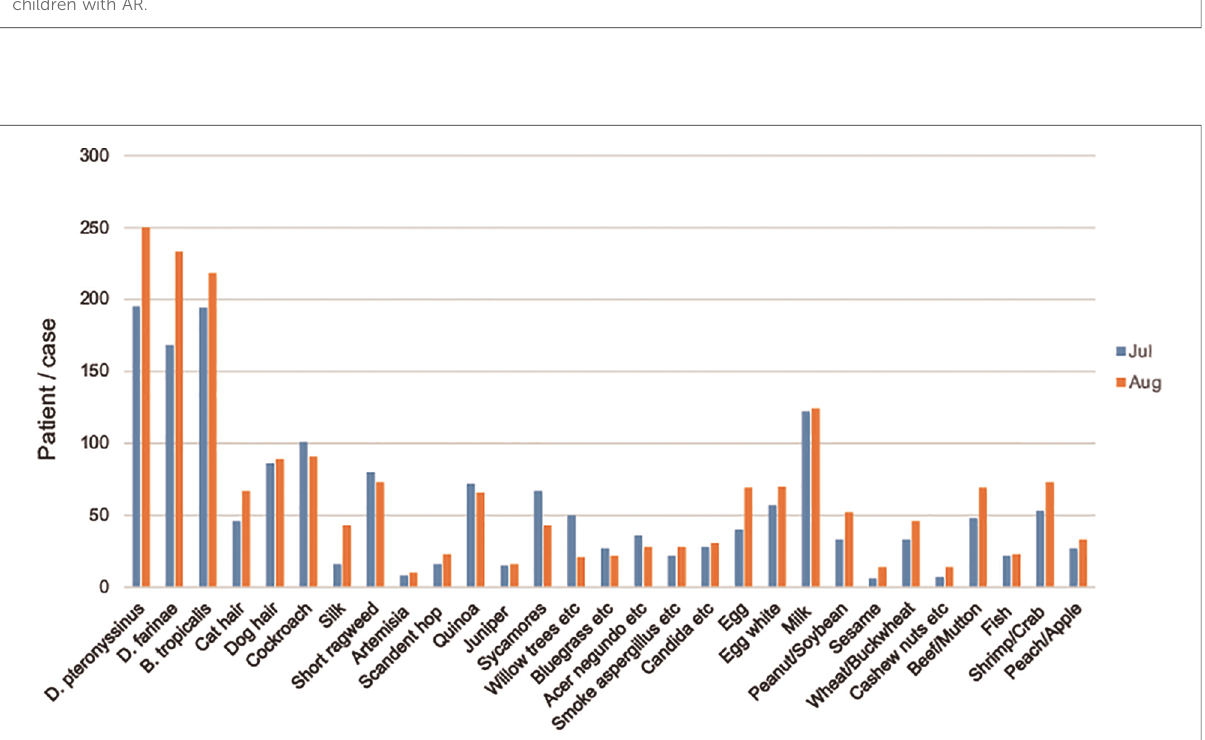
FIGURE 4 Distribution of allergens in children with AR in July and August. The abscissa represents different allergens, and the ordinate represents the number of children with AR. The blue color stands for July, and the orange color stands for